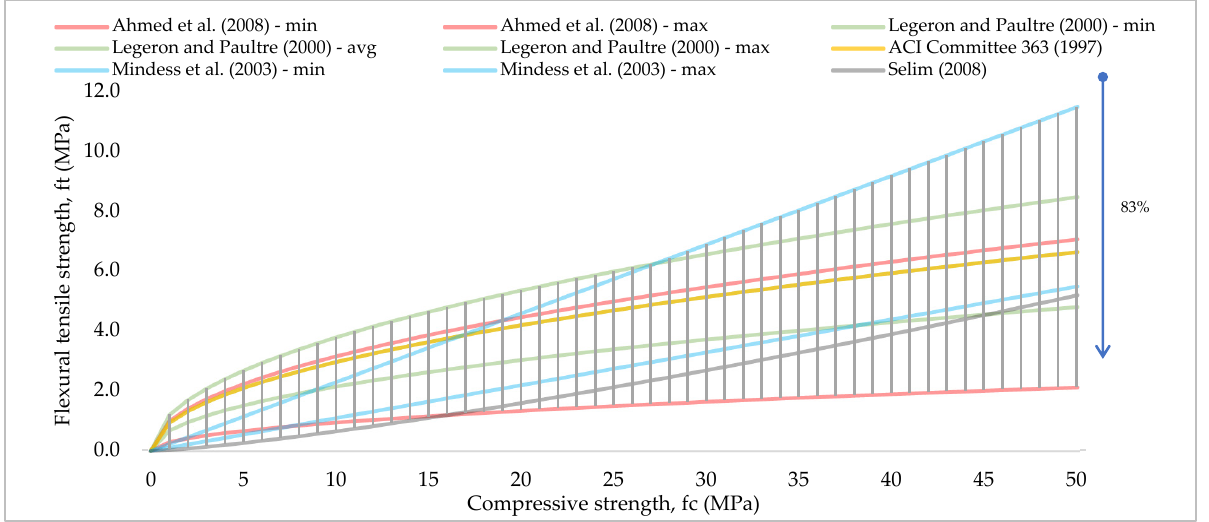
Figure 3. Correlation between Flexural tensile strength and Compressive strength (Equations (12)–(16)) [47].